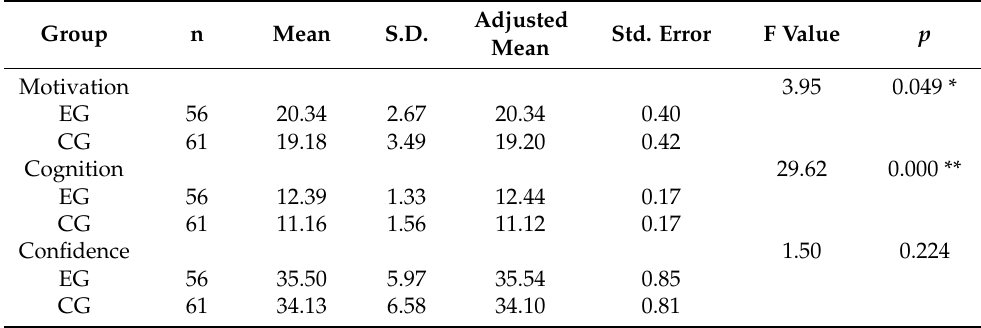
Table 2. Summary of ANCOVA on the post-test of motivation, cognition, and confidence between two